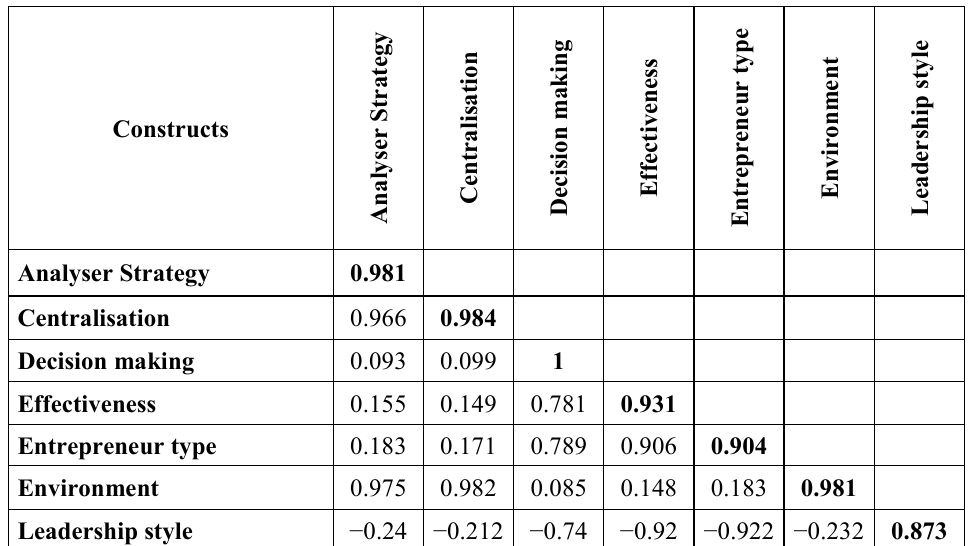
Table 3. Latent Variable